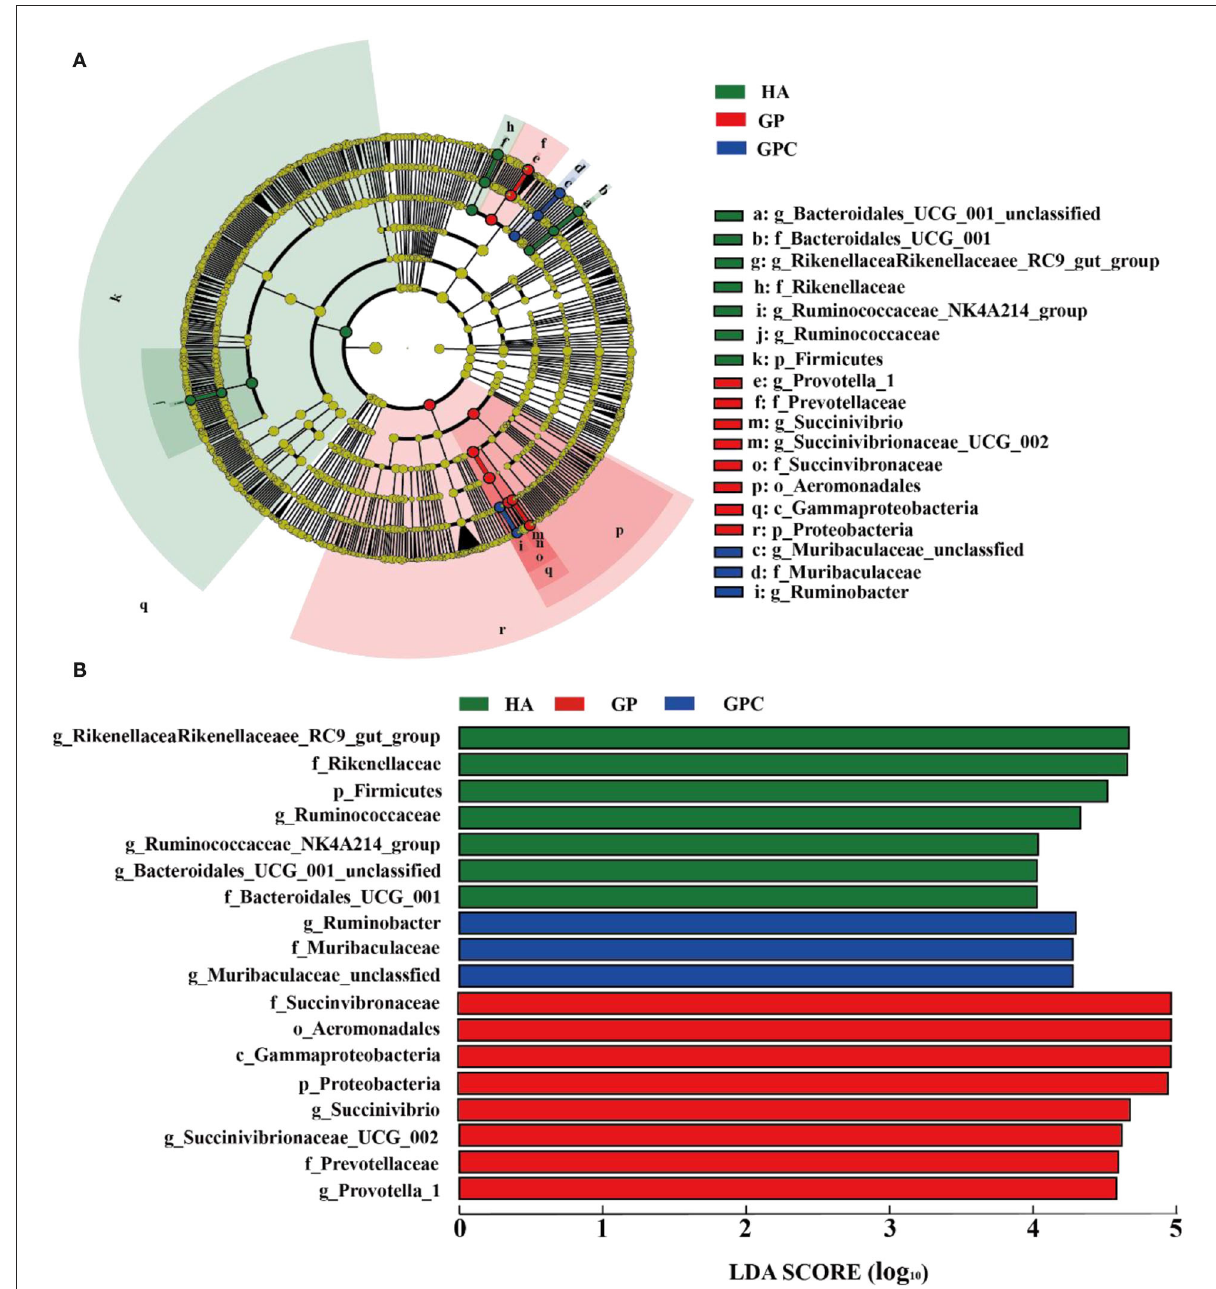
FIGURE4 Linear discrimination analysis (LDA) coupled with effect size (LEFSe) analysis of the rumen microbial community of lamb in the HA, GP and GPC groups ( n = 6). (A) Cladogram showing microbial species with significant differences among the three treatments. Red, green, and blue represent different groups. Species classification at the phylum, class, order, family, and genus level are displayed from inner to outer layers. The red, green, and blue nodes represent microbial species in the phylogenetic tree that play important roles in the HA, GP, and GPC groups, respectively. Yellow nodes represent no significant difference between species. (B) Significantly different species with an LDA score greater than the estimated value (default score = 4). The length of the histogram represents the LDA score of different species in the three groups. HA, non-pelleted native grass hay diet, GP, pelleted native grass hay diet; and GPC, pelleted native grass hay with concentrated diets.